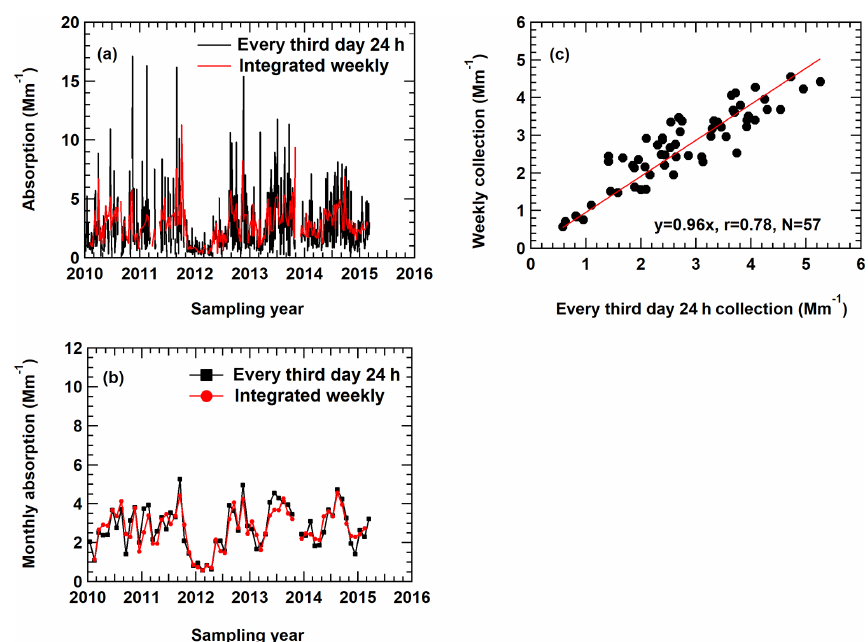
Figure 1. (a) Real-time particle soot absorption photometer (PSAP) measurements averaged to match the corresponding sampling frequencies used in different networks. (b) Monthly PSAP measurements derived from (a) . (c) Comparison of the different sets of measurements from (b) with the 1 : 1 line shown in